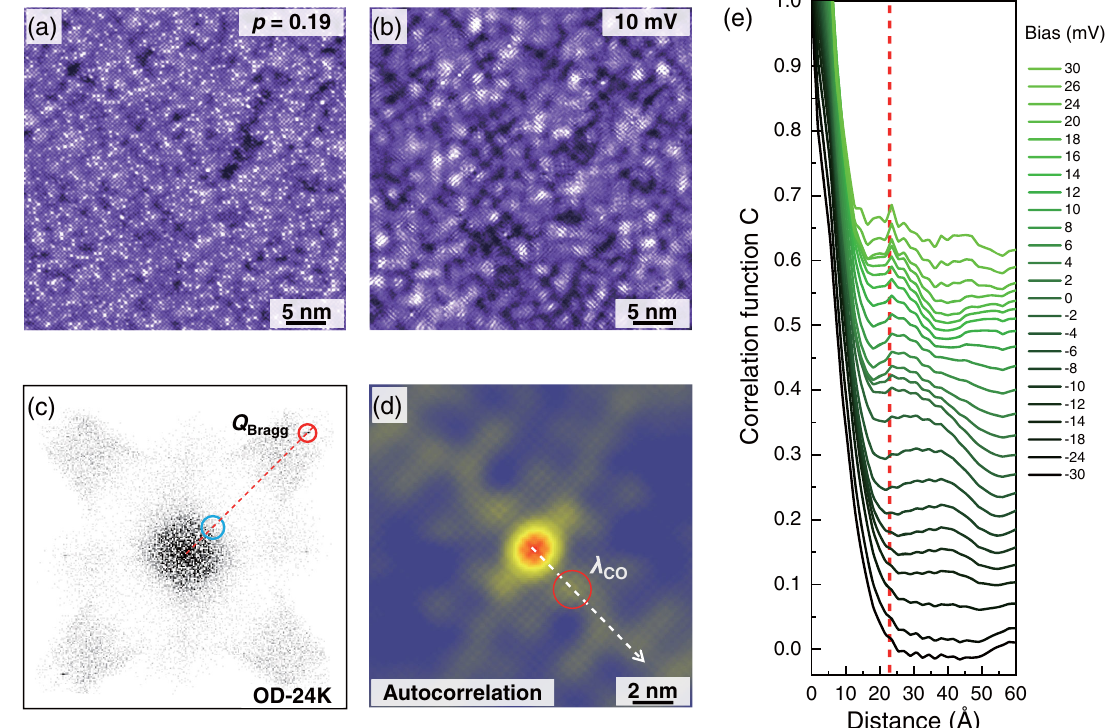
FIG. 2. The overdoped OD-24K sample with p ¼ 0 . 19 . (a) Atomically resolved topographic image acquired at V ¼ 100 mV and I ¼ 5 pA over an area of 400 × 400 Å 2 . (b) The dI=dV map measured in the same area as (a) at bias voltage V ¼ 10 mV. (c) The Fourier transform map of (b), where the blue circle indicates the absence of a FT peak for the checkerboard order. (d) The autocorrelation map of (b), where the short-range charge order is revealed by four bright spots in a red circle. (e) Bias-dependent autocorrelation intensity AC ð R Þ linecuts along the Cu ─ O bond direction. The red dashed line indicates the nondispersive charge order